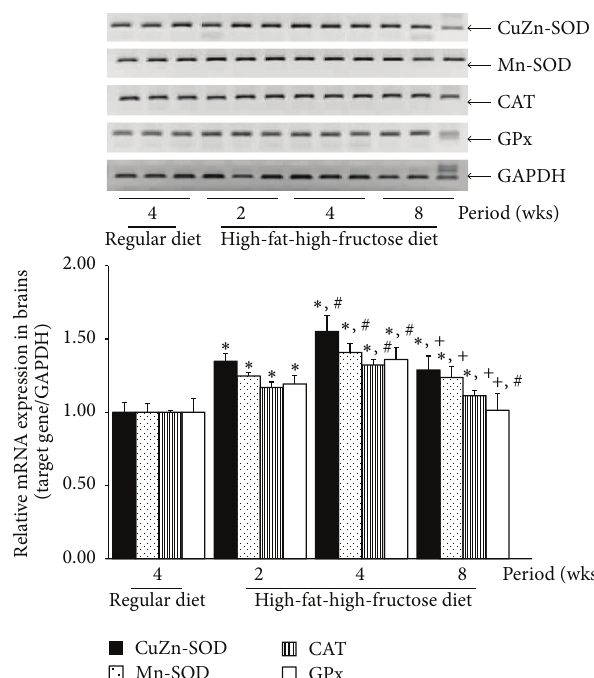
Figure 6: Effects of a high-fat, high-fructose diet on CuZn-SOD, Mn-SOD, CAT, and GPx mRNA expression in the mouse brains. Mice were fed a commercial standard diet for 4 weeks, and a high-fat, high-fructose diet (HFFD) was administered intragastrically for 2, 4, or 8 weeks. A semiquantitative determination of the mRNA expression of certain genes in mouse brain was performed using pairs of primers specific to the investigated genes. The data are presented as the mean ± SD ( 𝑛 = 5 ). Significant differences were determined using a one-way analysis of variance (ANOVA) followed by Tukey’s post hoc test. ∗ 𝑝 < 0.05 versus the regular diet mice; # 𝑝 < 0.05 versus 2-week HFFD mice; + 𝑝 < 0.05 versus 4-week HFFD mice.